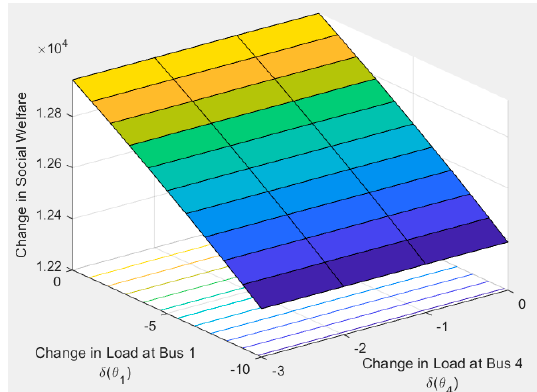
Figure 8. Equi-cost contour plots as a function of two variable loads in the IEEE 30-bus system; Bus 1 and 4.